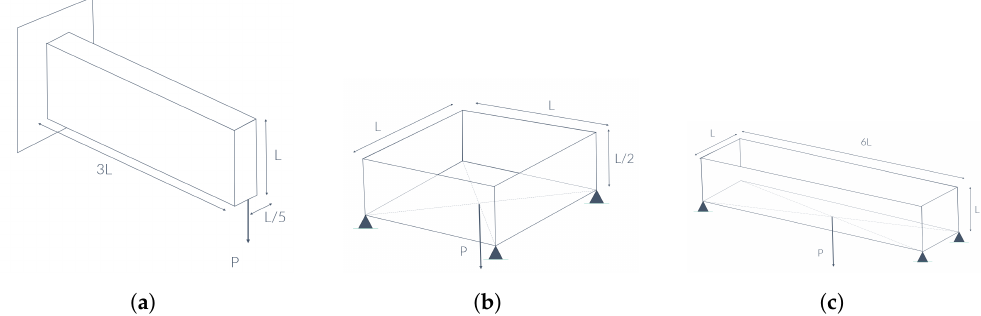
Figure 1. The macro domains of the three considered test examples. ( a ) 3D Cantilever Beam test example. ( b ) 3D wheel test example. ( c ) 3D MBB beam test